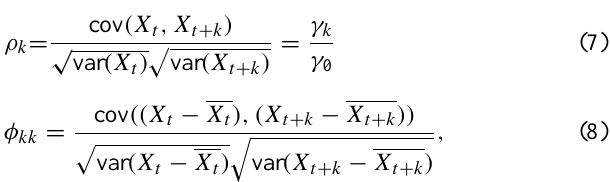
Figure15. Dominant wave period Tp auto correlation with 1hr time lag